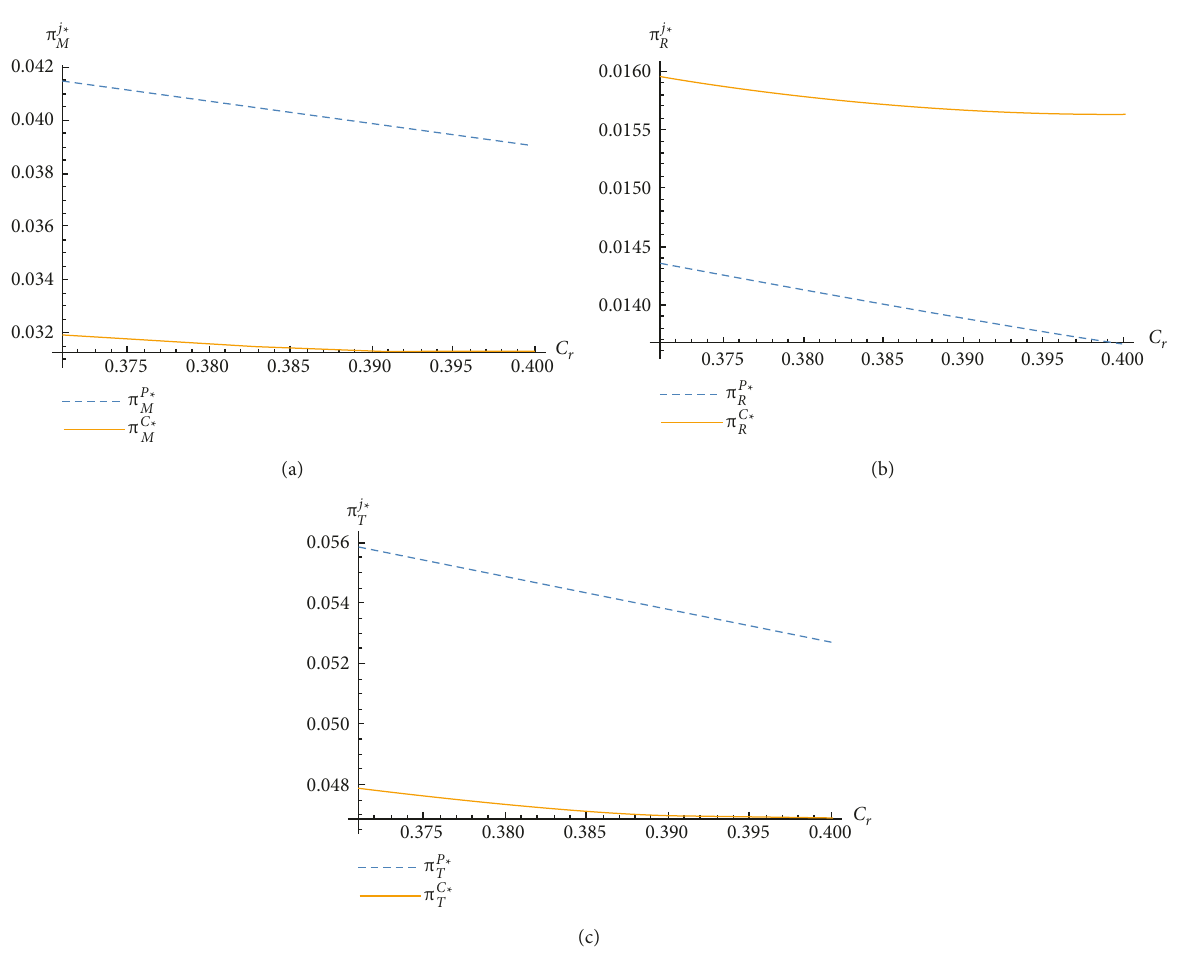
j ∗ c r on π R ; (c) effects of